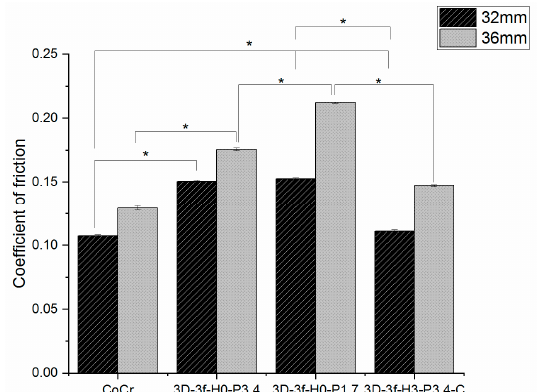
Figure 2. Coefficient of the friction of coated and non-coated 32 and 36 mm hip head implants during the reciprocal wear test against UHMWPE discs. * indicates a statistically significant difference between groups.